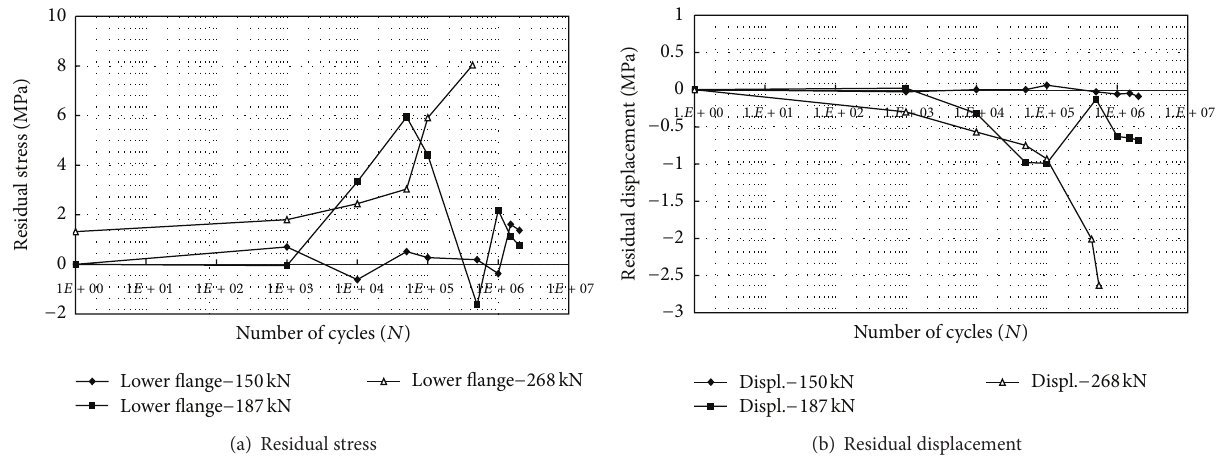
Figure 10: Correlation between cycle load-residual stress and displacement.